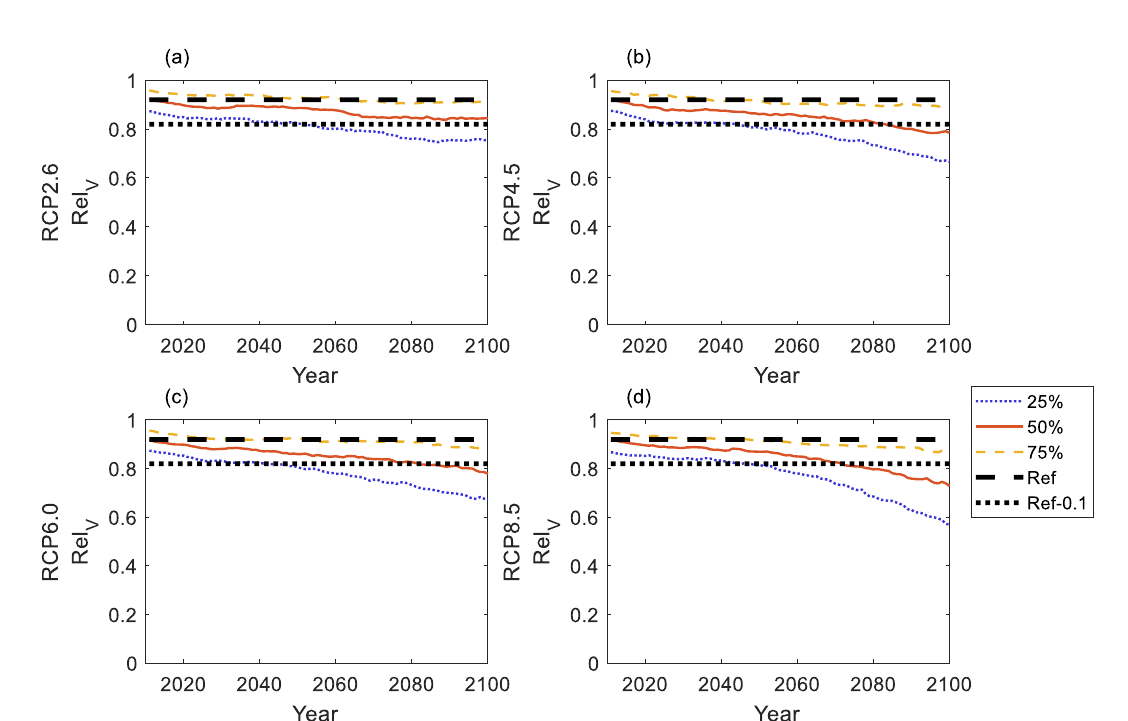
Figure 7. Resilience under RCP 2.6 ( a ), 4.5 ( b ), 6.0 ( c ), and 8.5 ( d ) for a 40-year moving window, with the horizontal axis being the last year of the window. The thick dashed and dotted lines represent the reference historical performance and 10% worse-than-the-reference value, respectively.